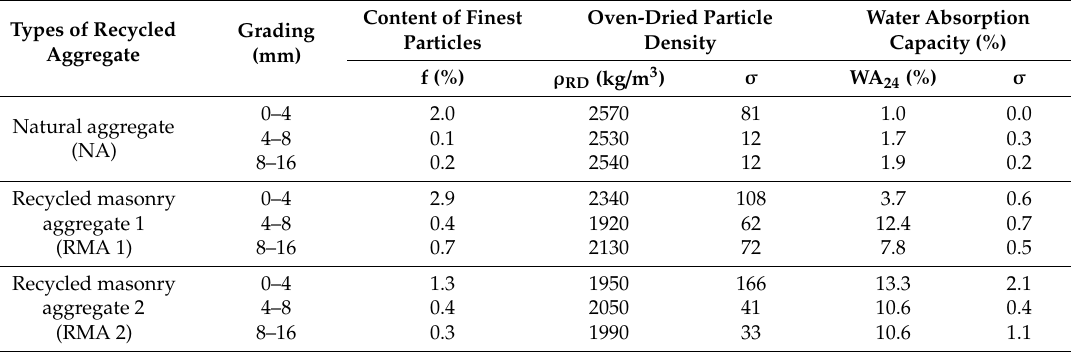
Figure 2. Sieving curves for natural aggregate, recycled masonry aggregate with limits defined in the standard [77] used in concrete mixtures. Table 1. Physical properties of particular fractions of used